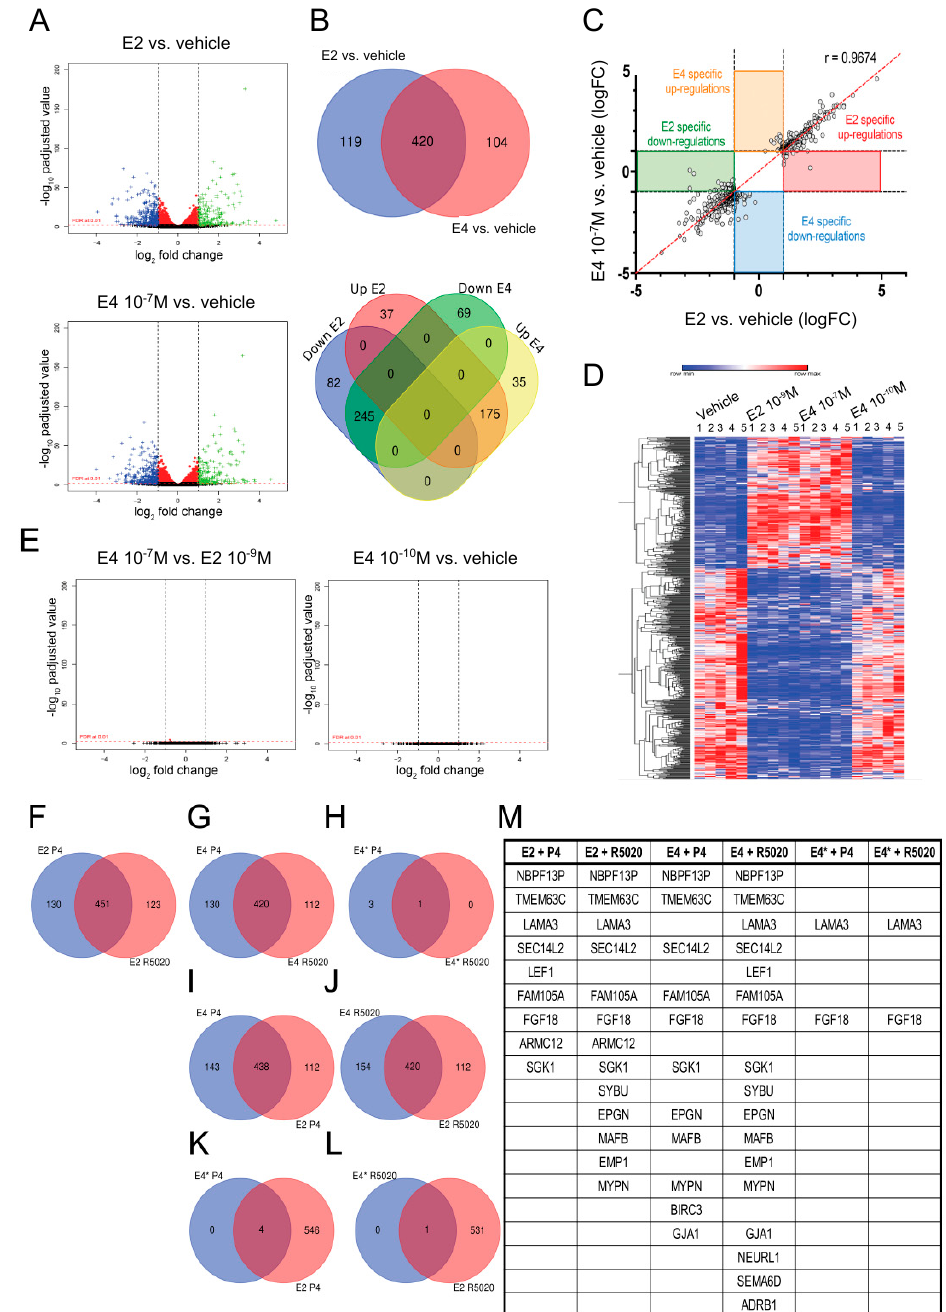
Figure 6. E2 and E4 transcriptomic profiles. ( A ) Volcano plot, using a parametric edgeR approach to identify differentially expressed (DE) genes, comparing E2 or E4 (10 − 7 M) to vehicle from five independent replicates per condition. ( B ) Venn